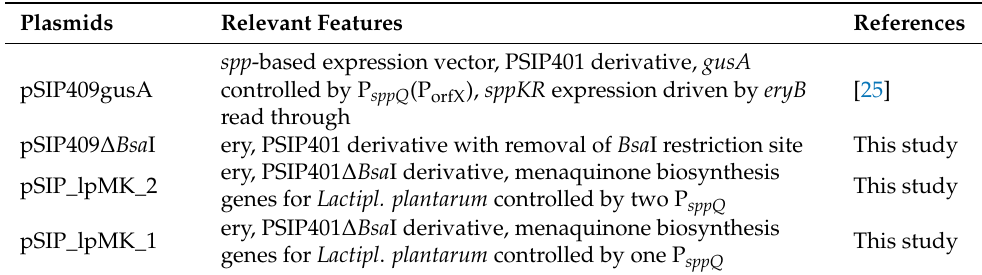
Table 2. Plasmids used and menaquinone expression plasmid constructs for two Lactobacillus strains. Plasmids Relevant